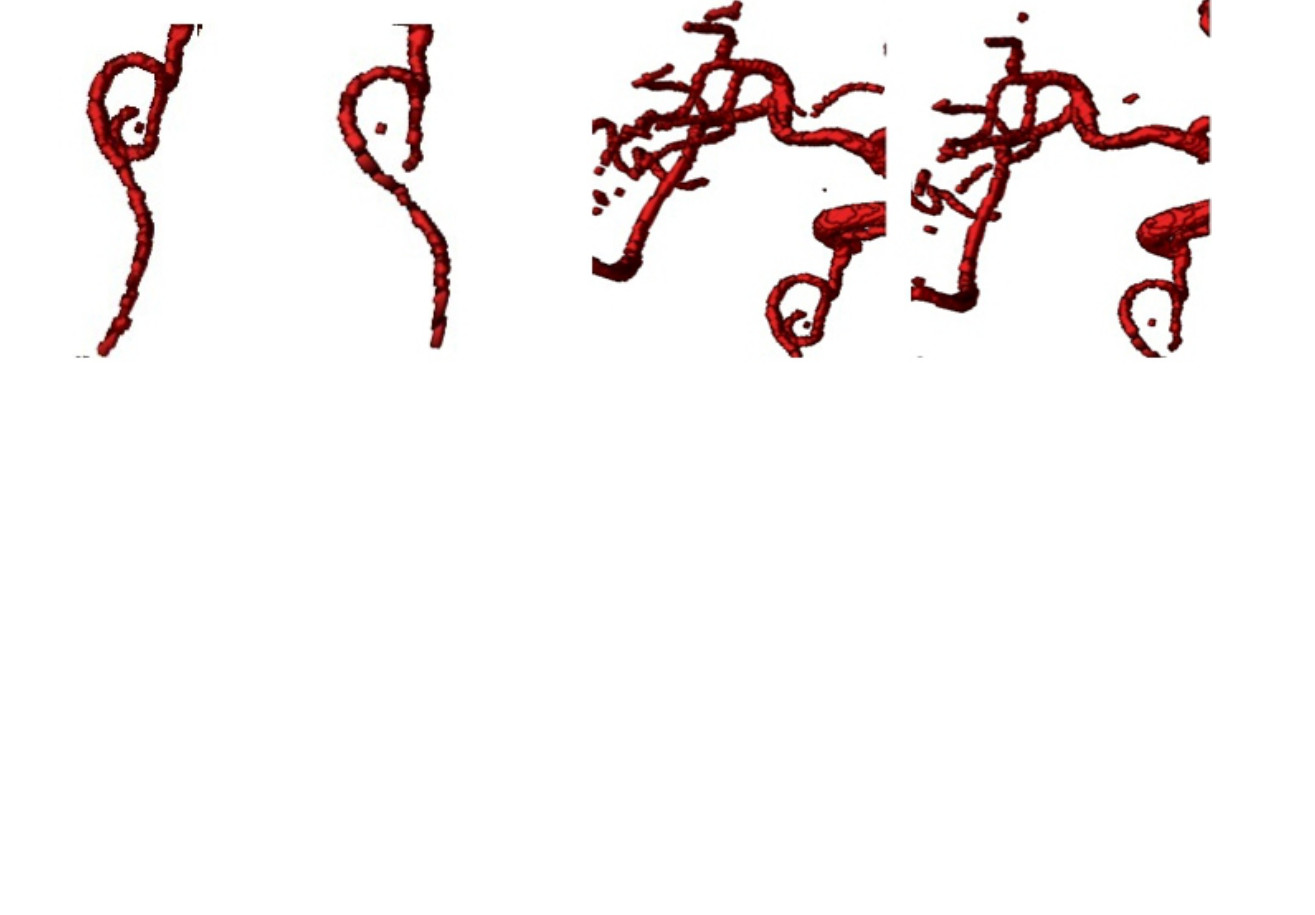
Figure 8. Comparison of segmentation details between G-MRF model and double Gaussian model of example data. From left to right: Detail 1 of G-MRF segmentation; detail 1 of Double Gauss segmentation; Detail 2 of Double Gauss segmentation; Detail 2 of G-MRF